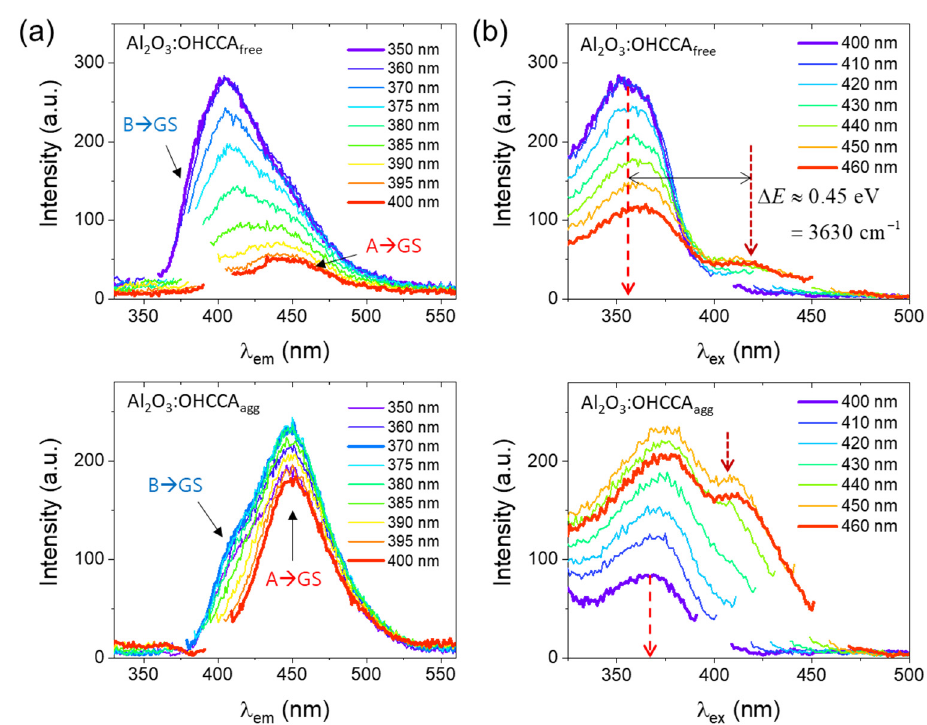
Figure 2. Steady-state ( a ) fluorescence emission spectra at selected excitation wavelengths ( λ ex ) and ( b ) fluorescence excitation spectra at selected emission wavelengths ( λ em ) for Al 2 O 3 :OHCCA free (top) and Al 2 O 3 :OHCCA agg (bottom), which were taken from the fluorescence-excitation 2D image (see Figure S3 for the raw image).